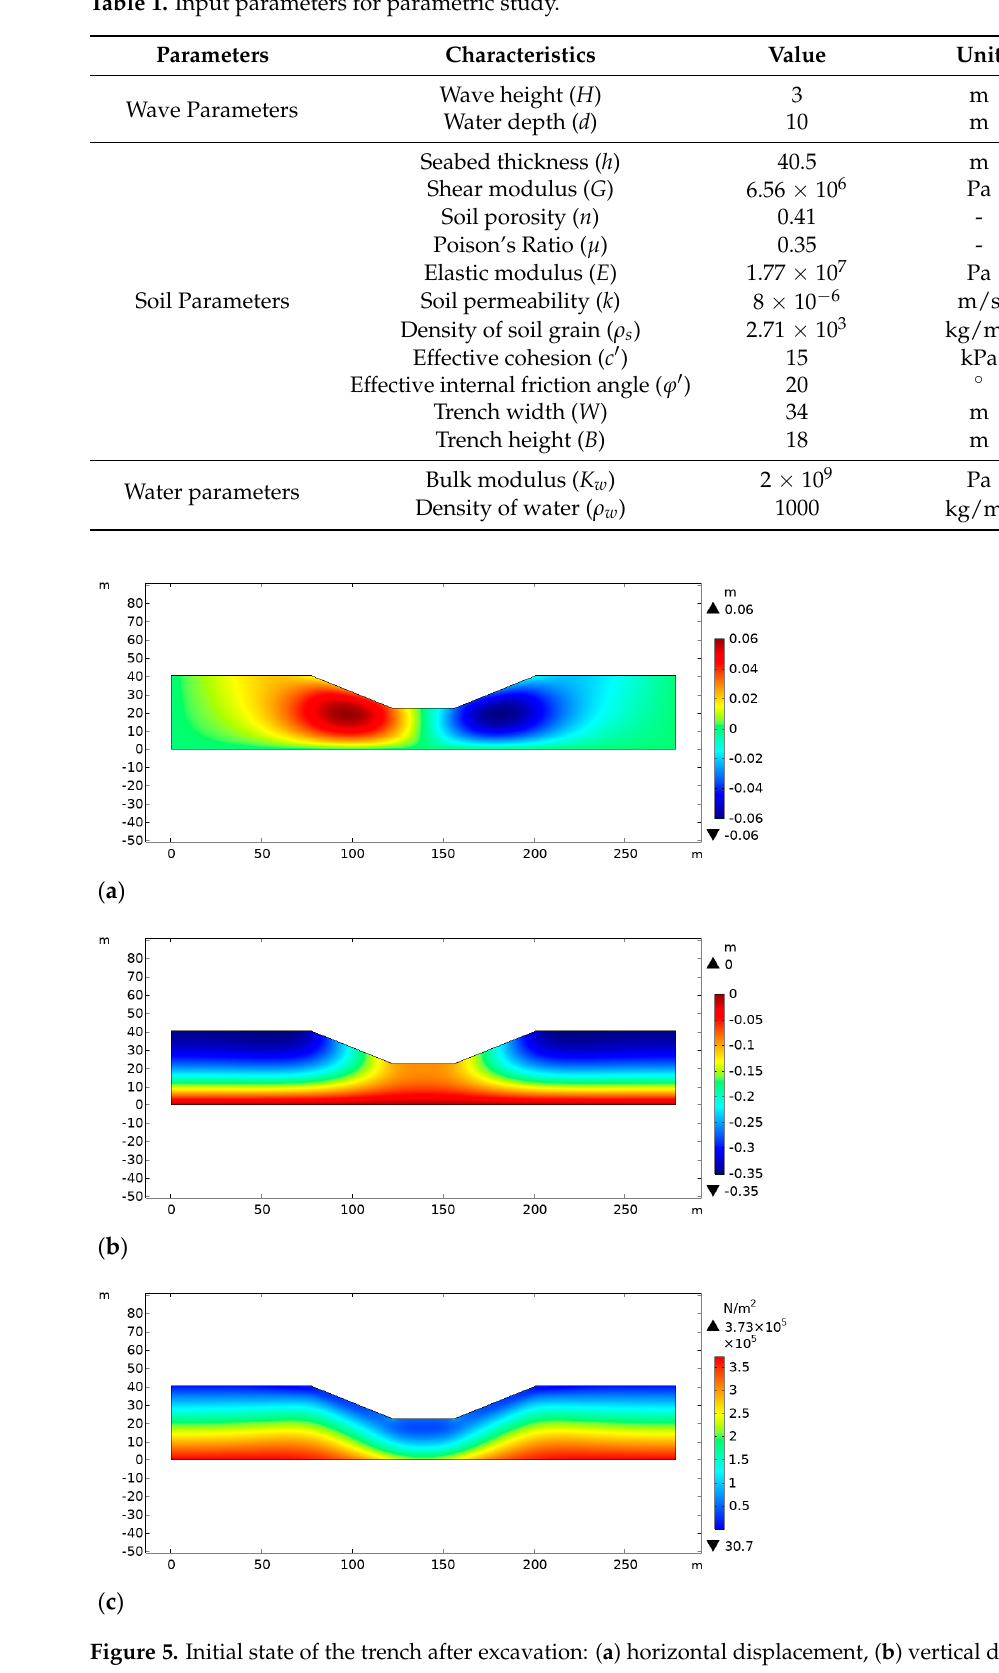
Figure 5. Initial state of the trench after excavation: ( a ) horizontal displacement, ( b ) vertical displacement, ( c ) stress state.